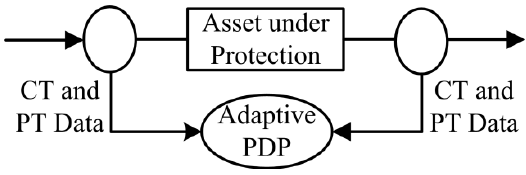
Fig. 2. Proposed Adaptive Power Differential Protection (APDP)